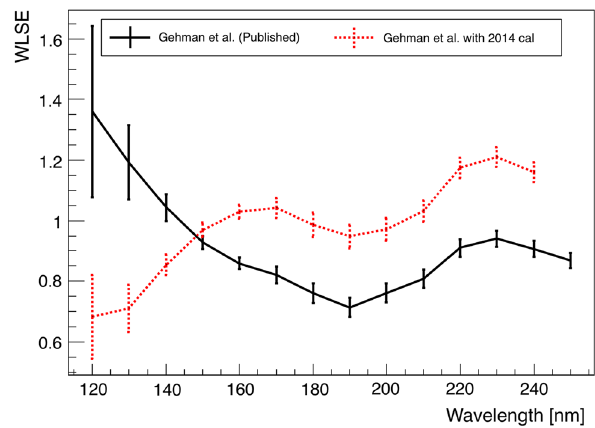
Fig. 22 A comparison of the published results in [16] (solid line) to a reanalysis of the raw data from [16] using the 2014 calibration (dotted line). When the 2014 calibration is applied, the result from [16] has a similar shape as the results from this work. The scale offset is explained in Sect.